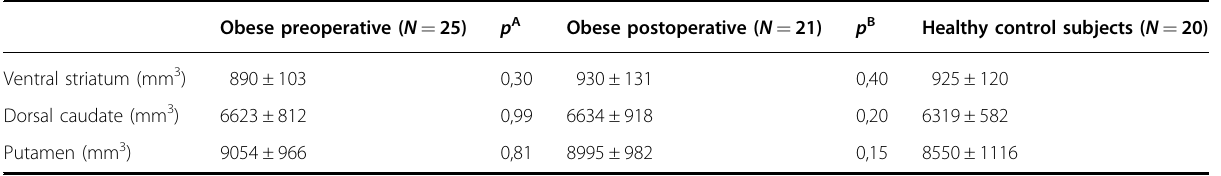
Table 2 Volumes of striatal